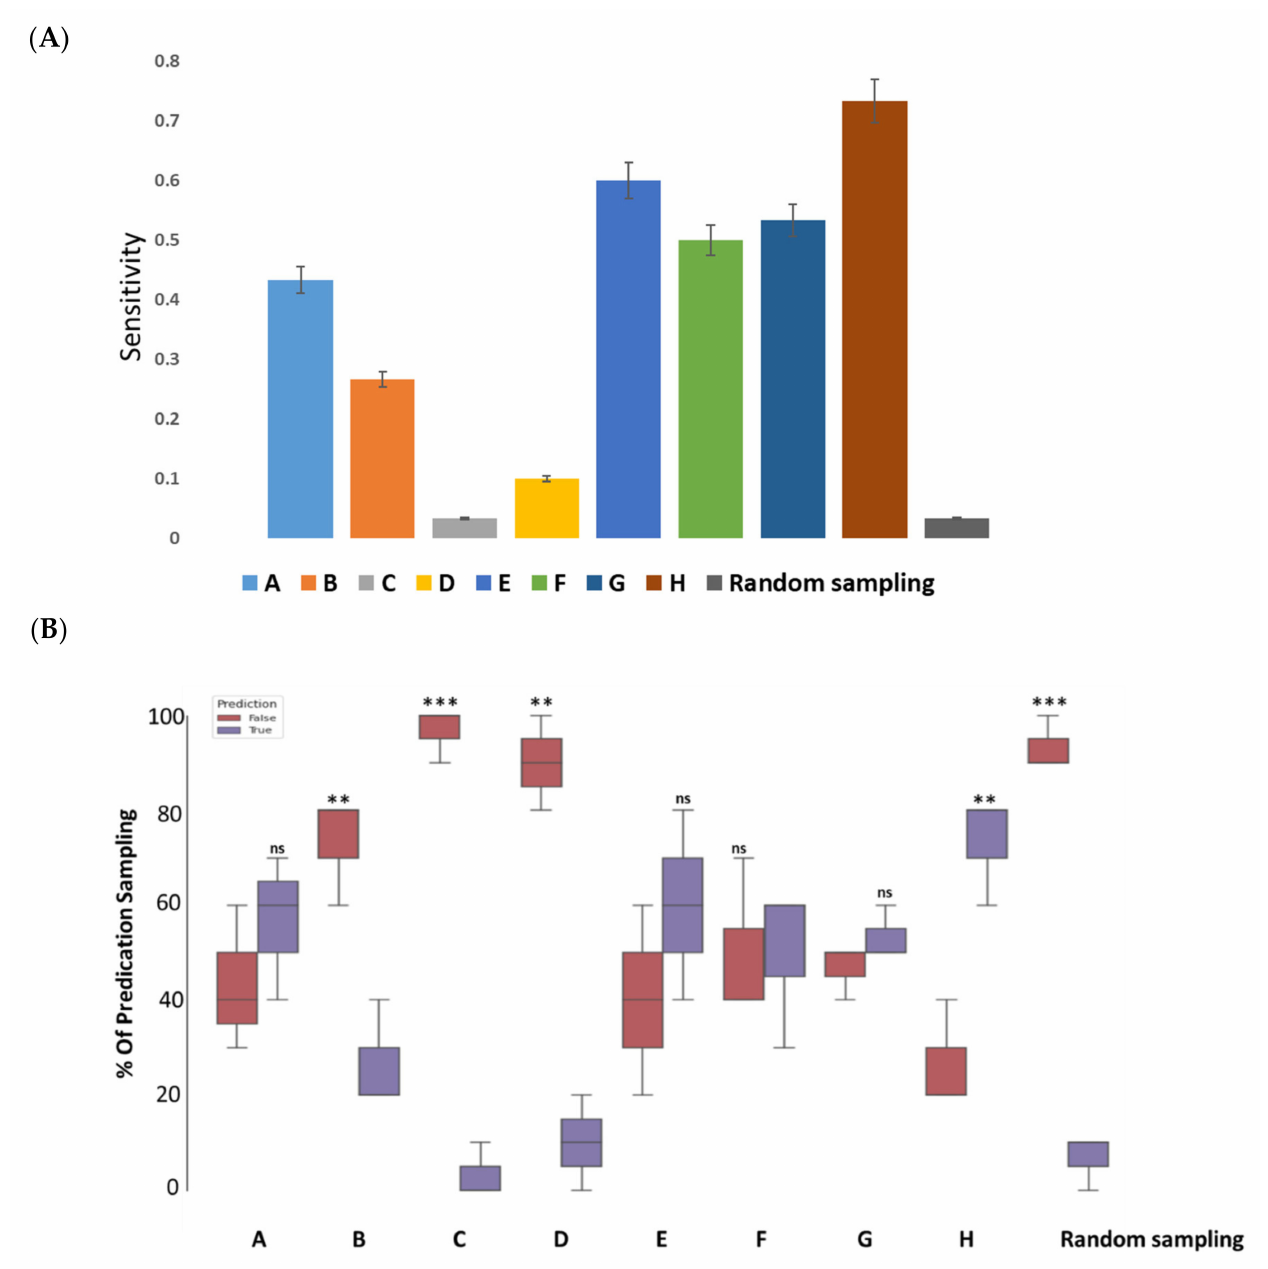
Figure 4. Sensitivity analysis for Adera2.0 extraction networks. ( A ) Normalized sensitivity for different architectures of the extraction network ( B ) Boxplot of True and negative prediction for various architectures of the extraction network. ** represents p -value of <0.001, *** represents p -value of <0.0001, while ns stand for